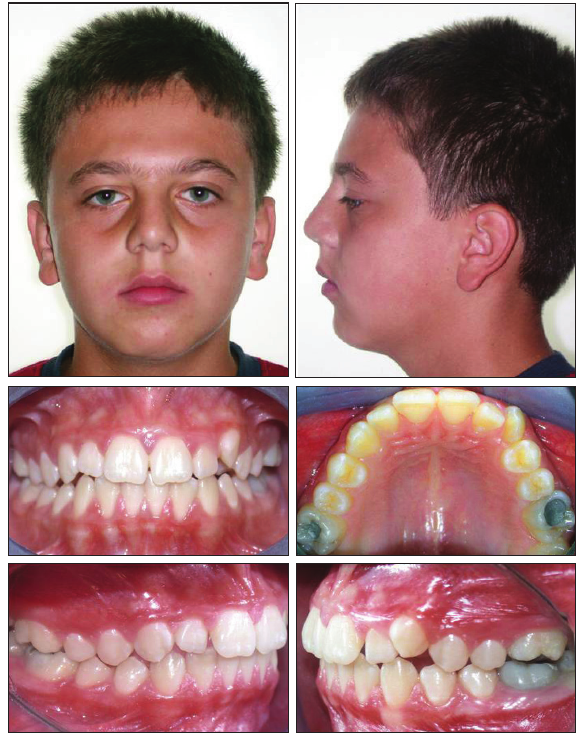
Figure 2. Pretreatment intra-oral and extra-oral photographs of a patient.